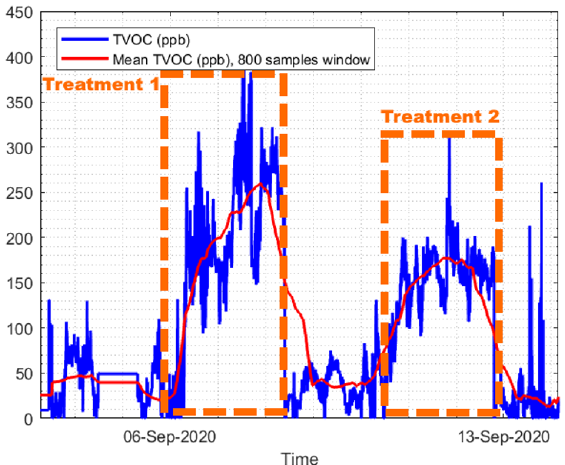
Figure 10. Collected TVOC samples (blue) and mean values (red), from the sugarloaf lettuce field, with identification of pesticides treatment. Table 2. Performed pesticides treatments, in the sugarloaf lettuce field, with mean TVOC detected peaks.